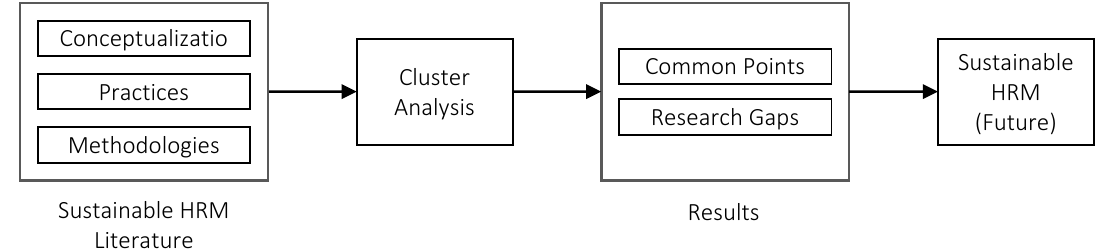
Figure 1. Conceptual framework for sustainable HRM